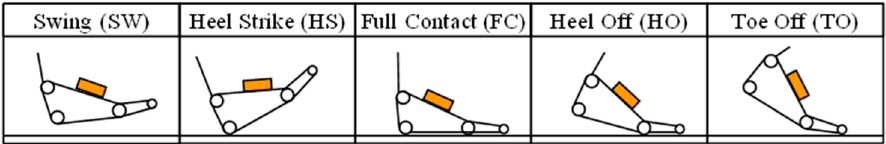
Figure 1. Foot–ground contact phase definition: swing, heel strike, full contact, heel off, and toe off.